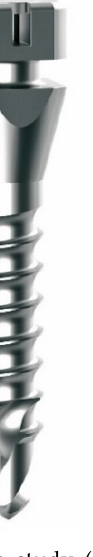
Figure 1. Self-drilling miniscrews used in the study (diameter of 1.75 mm, length of 8 mm, and high head).